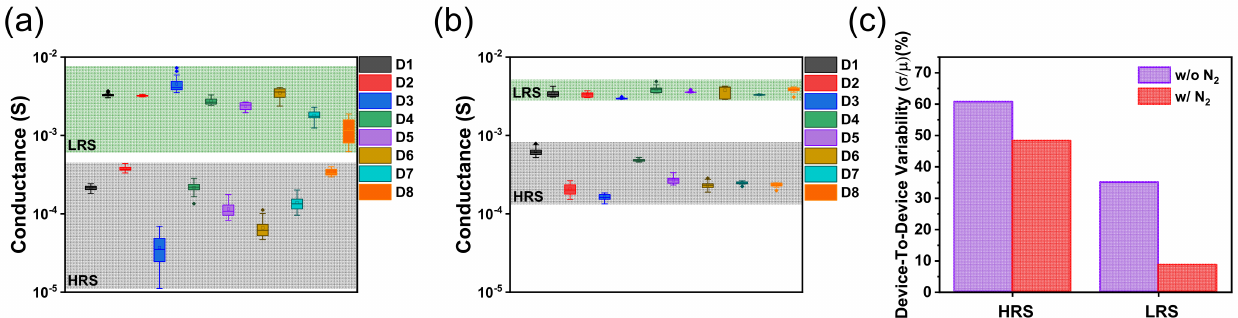
Figure 3. HRS and LRS distributions of eight randomly selected memory cells of ( a ) Ta/TaO x /Pt device and ( b ) Ta/TaO x :N/Pt device. ( c ) Device–to–device variation for two